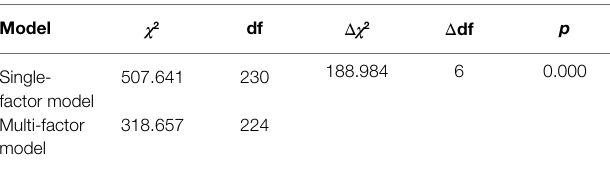
TABLE 2 | Comparison between the single-factor model and the multi-factor model. Model